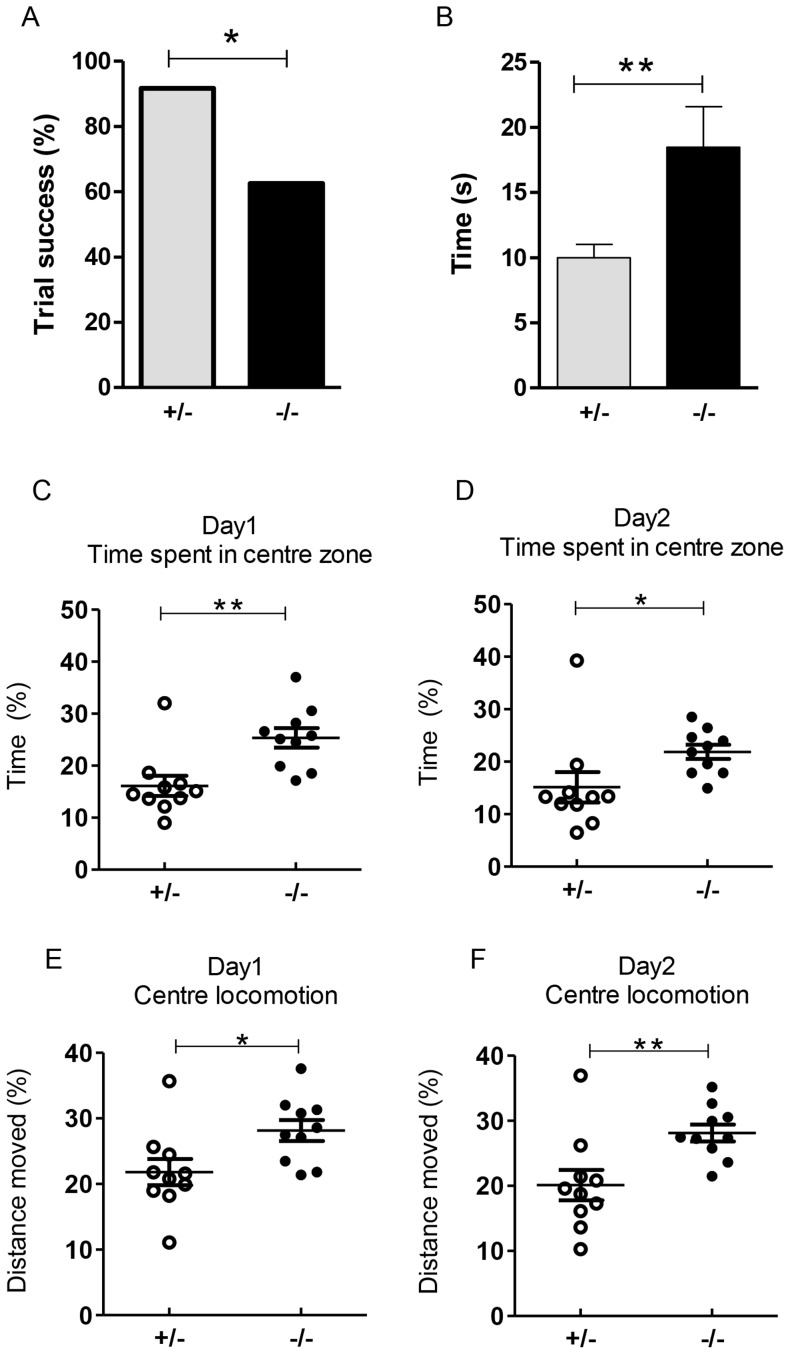
Reduced motor performance and thigmotaxis behaviour in Elfn1−/− mice.(A) Elfn1+/− mice completed a wire hang trial with a success rate of 91.67% and Elfn1−/− mice were only successful in 62.5% of the trials (n = 8/genotype; 3 trials per mouse; p = 0.0363). (B) The time taken to complete a successful trial was analysed and Elfn1−/− mice took considerably longer to reach a pole (p = 0.0054). Data expressed as mean±SEM (n = 22 for Elfn1+/− and n = 15 for Elfn1−/− mice). Student's t test was used to compare the means. (C,D) Percentage of total time spent in the centre zone on day 1 (C) and day 2 (D). Elfn1−/− mice spent more time in the centre zone than Elfn1+/− mice on both days (p = 0.0031 for day 1, and p = 0.0496 for day 2; n = 10/genotype). (E,F) Percentage of total distance travelled in the centre zone on day 1 (E) and day 2 (F). Elfn1−/− mice travelled further than Elfn1+/− mice in the centre zone on both days (p = 0.023 for day 1 and p = 0.0076 for day 2). Student's t test used to identify statistical difference between the groups.